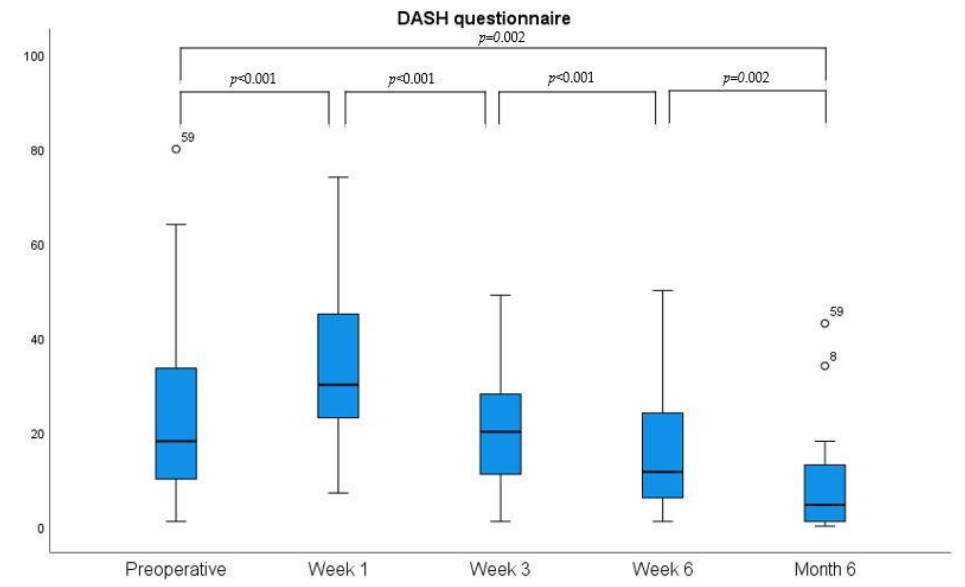
Figure 6. Development the Disabilities of Arm, Shoulder, and Hand (DASH) questionnaire over time. (° present outliers).